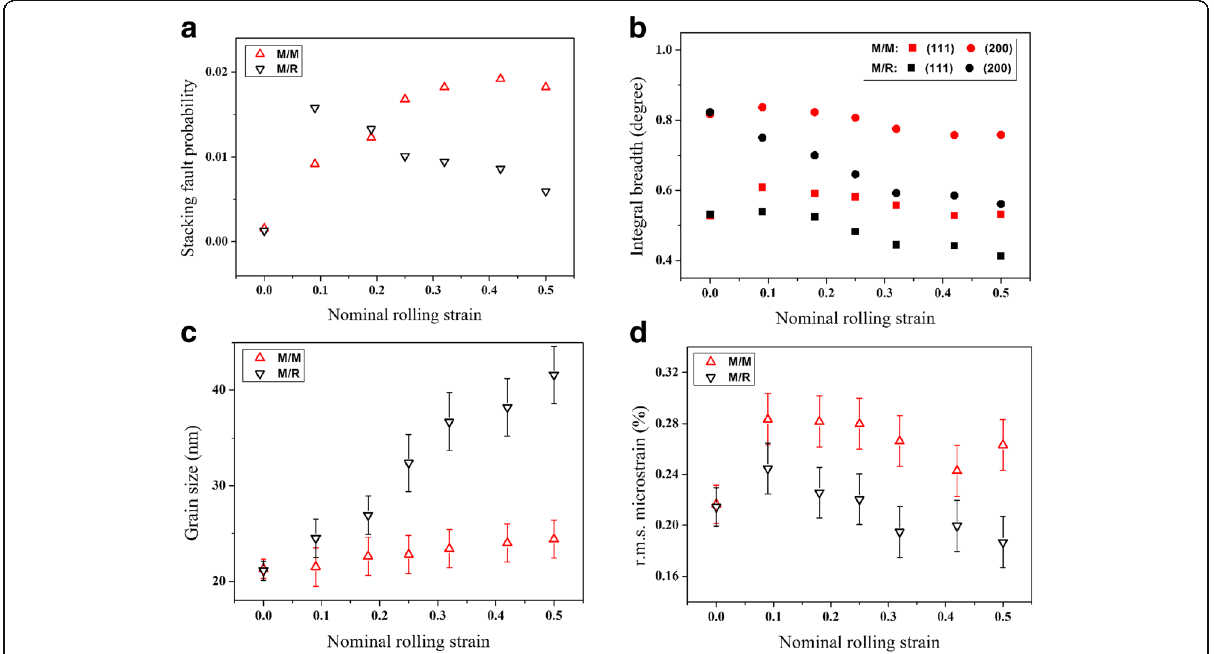
Fig. 2 Quantitative results of a stacking fault probability, b integral breadths for the (111) and (200) peaks, c grain size, and d r.m.s. microstrain obtained by X-ray diffraction line profile